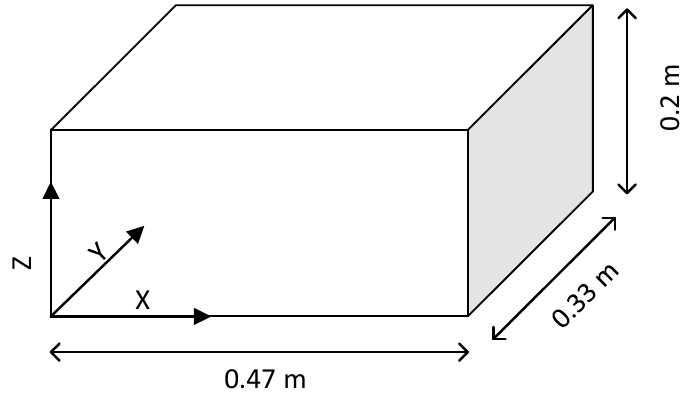
Figure 1. Experimental enclosure scheme of The University of Orléans. The research parameter combination is shown in Table